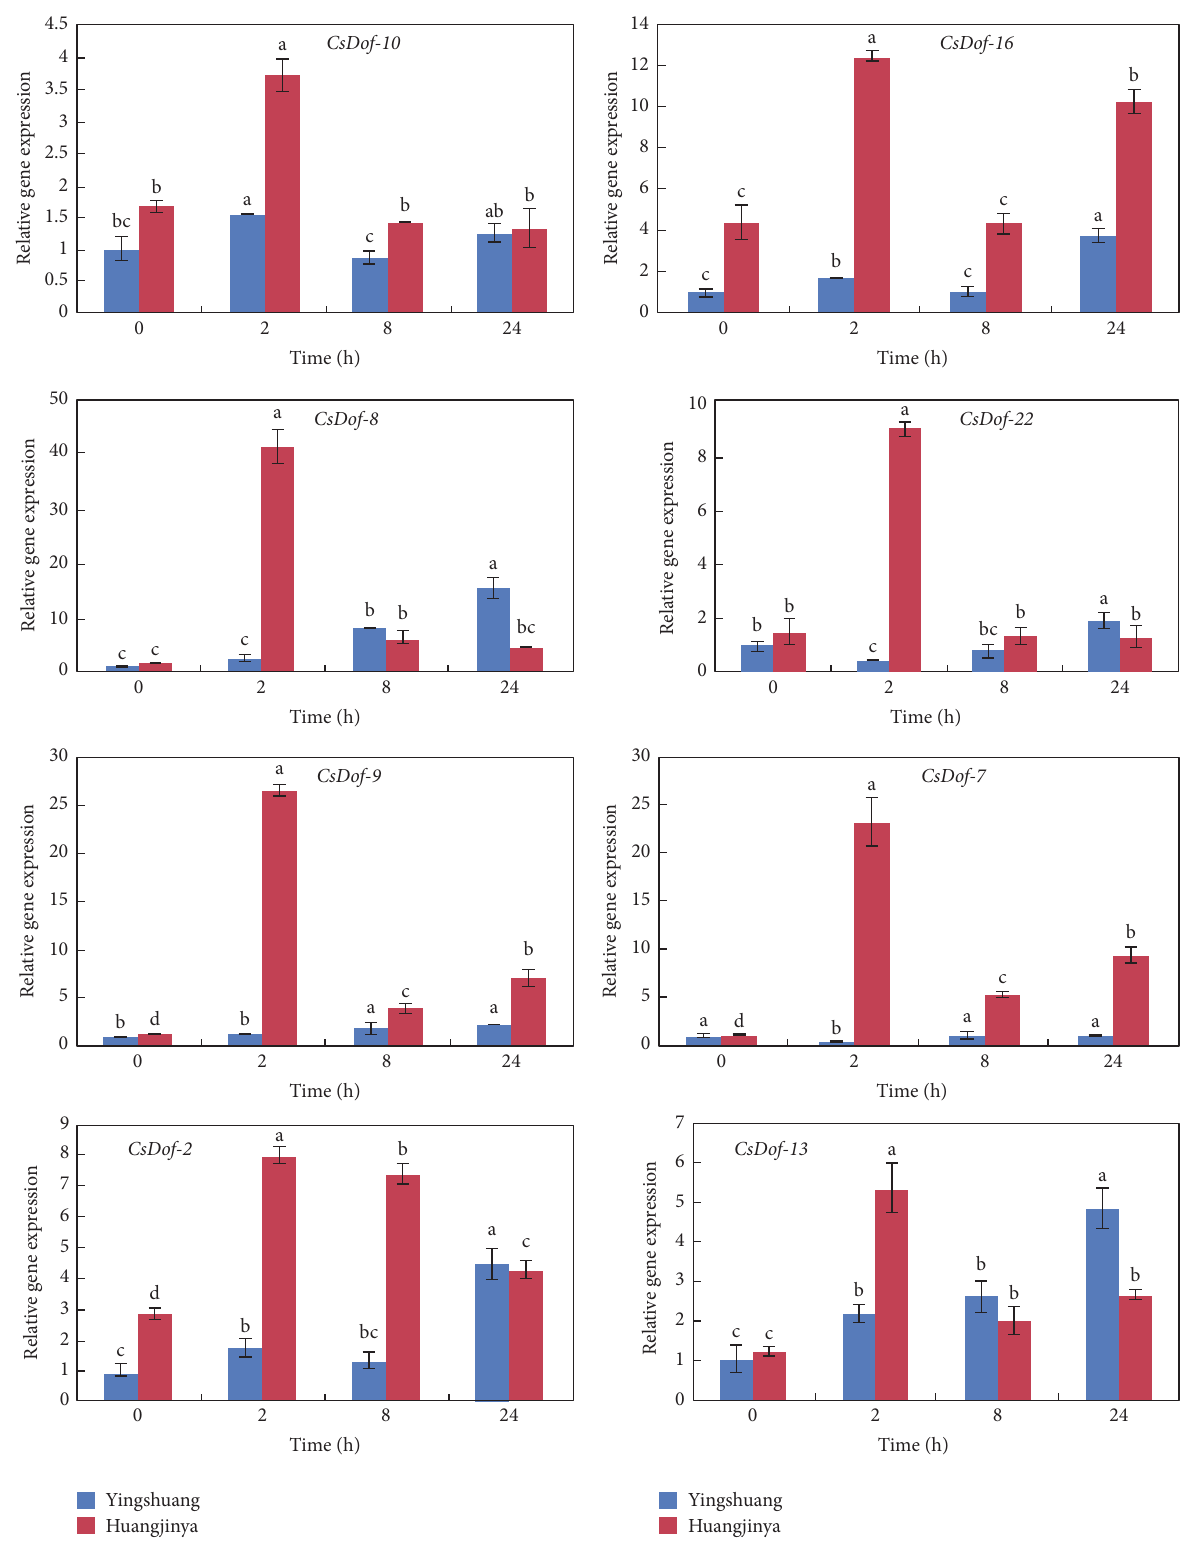
Figure 12: Expression patterns of CsDof genes in “Yingshuang” and “Huangjinya” under salt stress. Error bars represent standard deviation among three real-time quantitative PCR reaction replicates. Data are means of three technical replicates ± SD. Different lowercase letters indicate significant differences at 𝑃 < 0.05